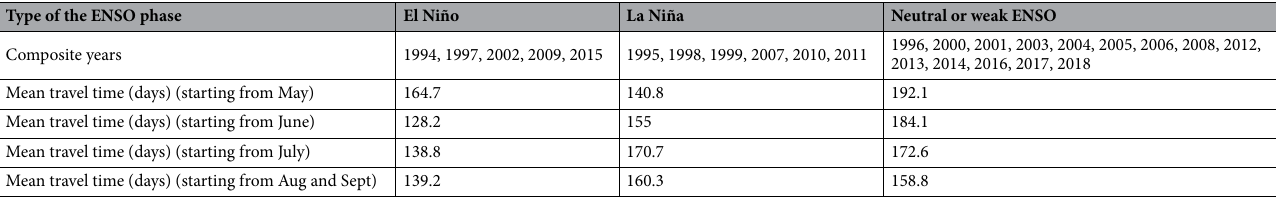
Table 2. Mean glass eel travel time for different ENSO